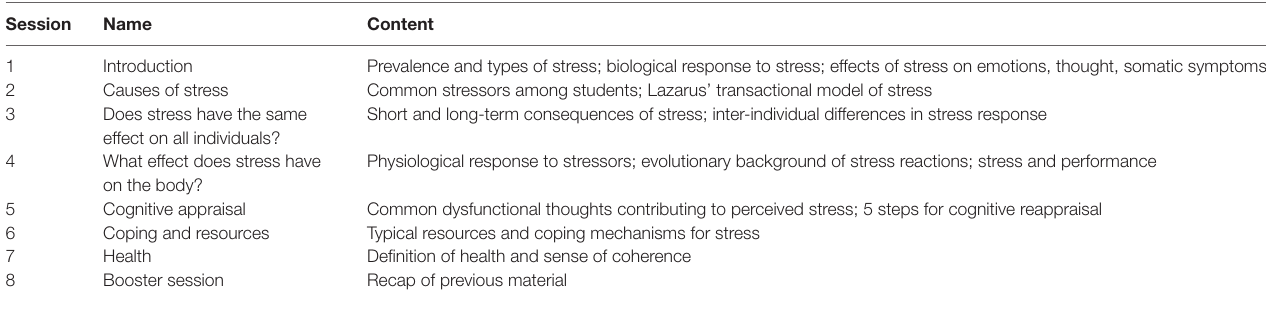
TABLE 2 | Psychoeducation modules in the control